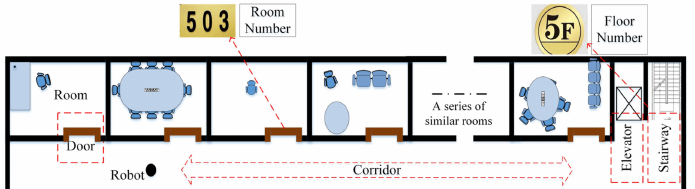
Figure 1. Text-level semantic information in similar